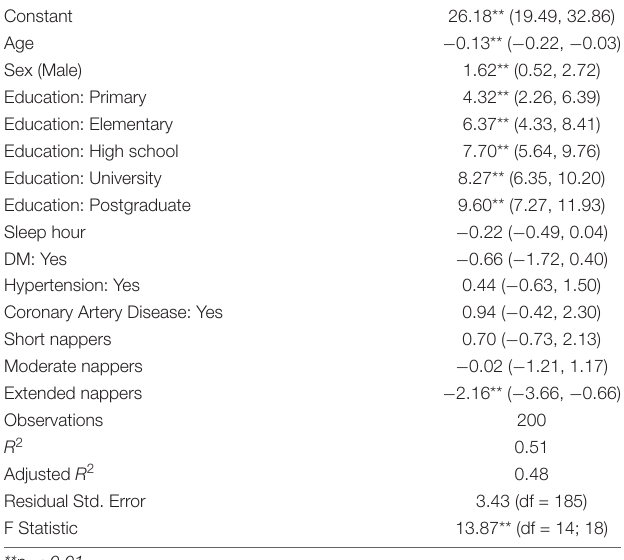
TABLE 2 | Multiple linear Regression dependent variable total SLUMS